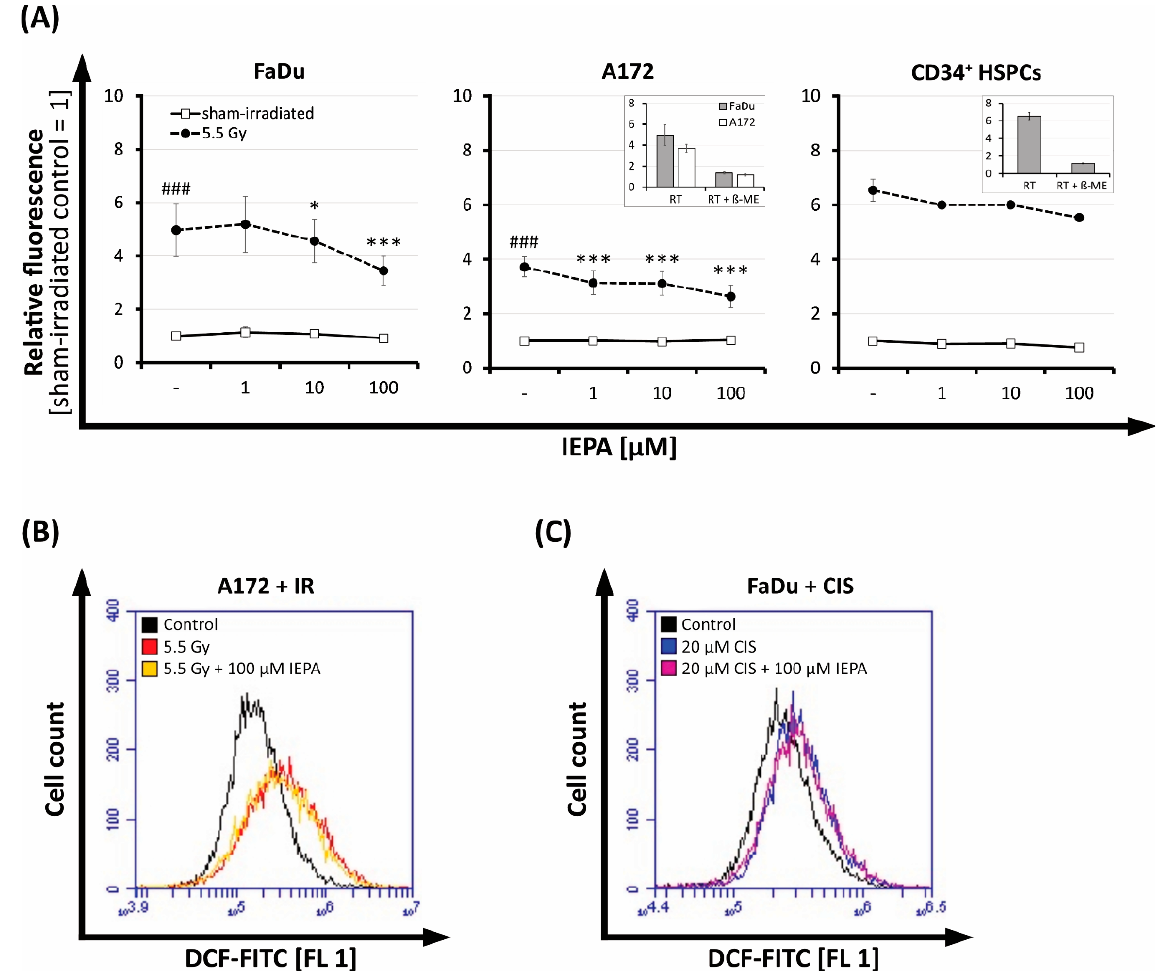
Figure 5. ( A ) Effect of IEPA (1, 10, 100 µ M) after IR (5.5 Gy) on intracellular ROS levels indicated by DCF fluorescence in FaDu and A172 cells (mean ± SEM of three experiments in triplicates or quadruplicates) as well as CD34 + HSPCs (mean ± SEM of one experiment in duplicates). Statistical significance obtained from analysis of variance (ANOVA) and Gabriel post hoc test displayed as asterisks (***) compared with irradiated control and as hashes (###) compared with sham-irradiated control. Inserts depict corresponding inhibition controls with 5 mM ß-mercaptoethanol ( β -ME). *, p ≤ 0.05. Flow-cytometric histograms of IEPA (100 µ M) effects compared with untreated control